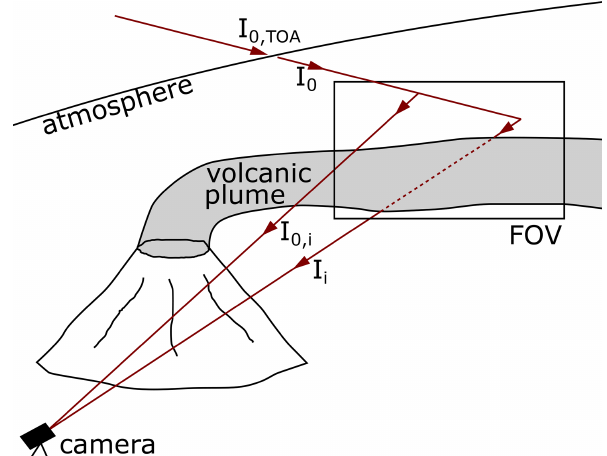
Figure 2. Schematic of the IFPICS measurement geometry, includ- ing the simulated radiances used in the instrument model. The in- cident top of atmosphere (TOA) radiation I 0 , TOA is propagating through the atmosphere and is potentially scattered into the IFPICS camera field of view (FOV), yielding the scattered skylight radiance I 0 . The camera records radiation in the respective FPI settings i = A and B that either traverses the volcanic plume I i or originates from a plume-free area within the FOV I 0 ,i